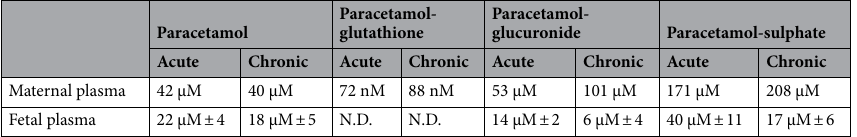
Placental permeability to paracetamol at E19. Figure 3 illustrates the level and time course of 3 H-par- acetamol transfer from maternal blood to fetal blood at E19 in animals treated with low doses of paracetamol either acutely or chronically (see above). Results of similar experiments with the high doses are shown below (from Ref. 2 ). The levels of radiolabelled drug were similar in the low and high doses of acutely and chronically treated animals but higher (about twofold) in the high dose chronically treated animals. The plasma levels of radioactivity declined in both fetuses and mothers during the course of the experiment but more so in the moth- ers’ plasma. Figure 4 shows estimates of placental transfer of radiolabelled paracetamol (fetal/maternal plasma ratios %) for the four treatment conditions. Overall fetal/maternal plasma ratios were about 45% indicating a